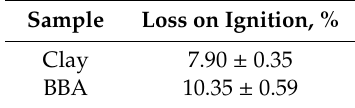
Table 4. Loss on ignition of clay and biomass bottom ash.